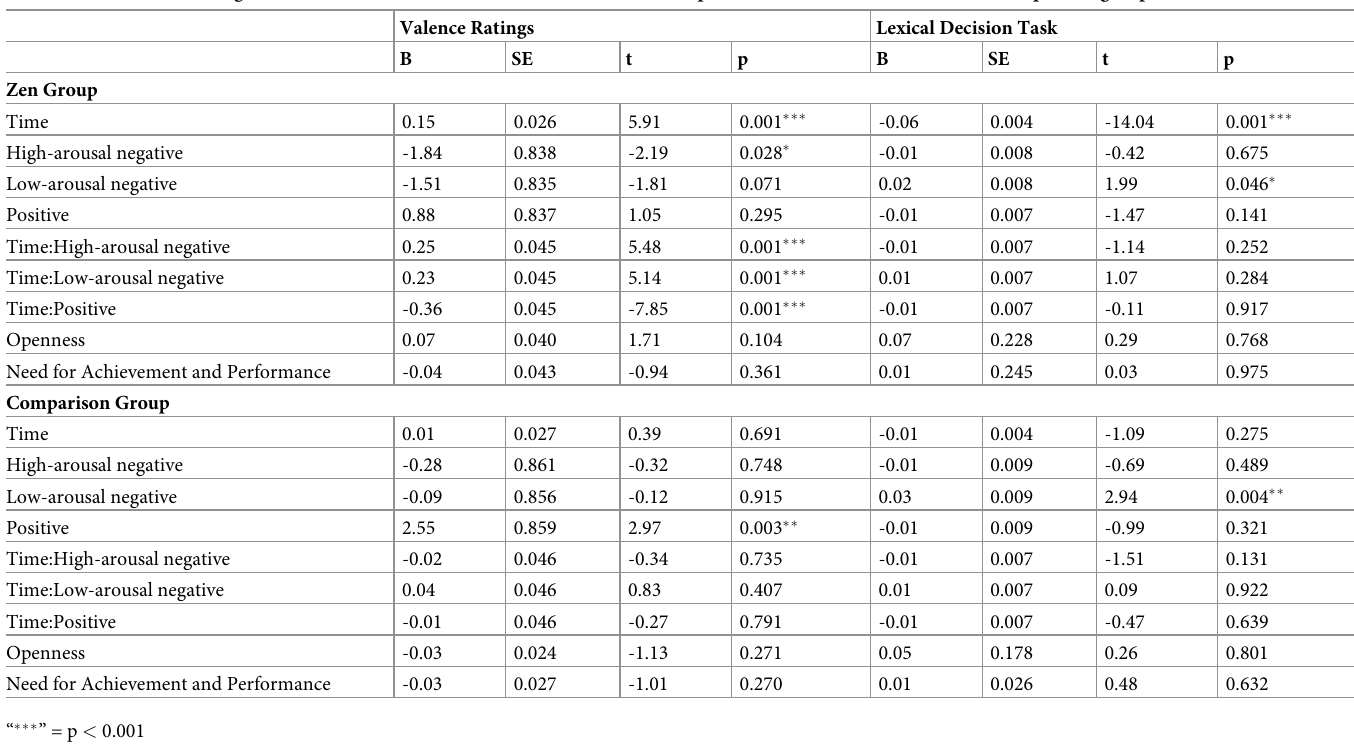
Table 3. Estimates of the regression coefficients, their standard errors, t-values and p-values for the LDT in the Zen and comparison